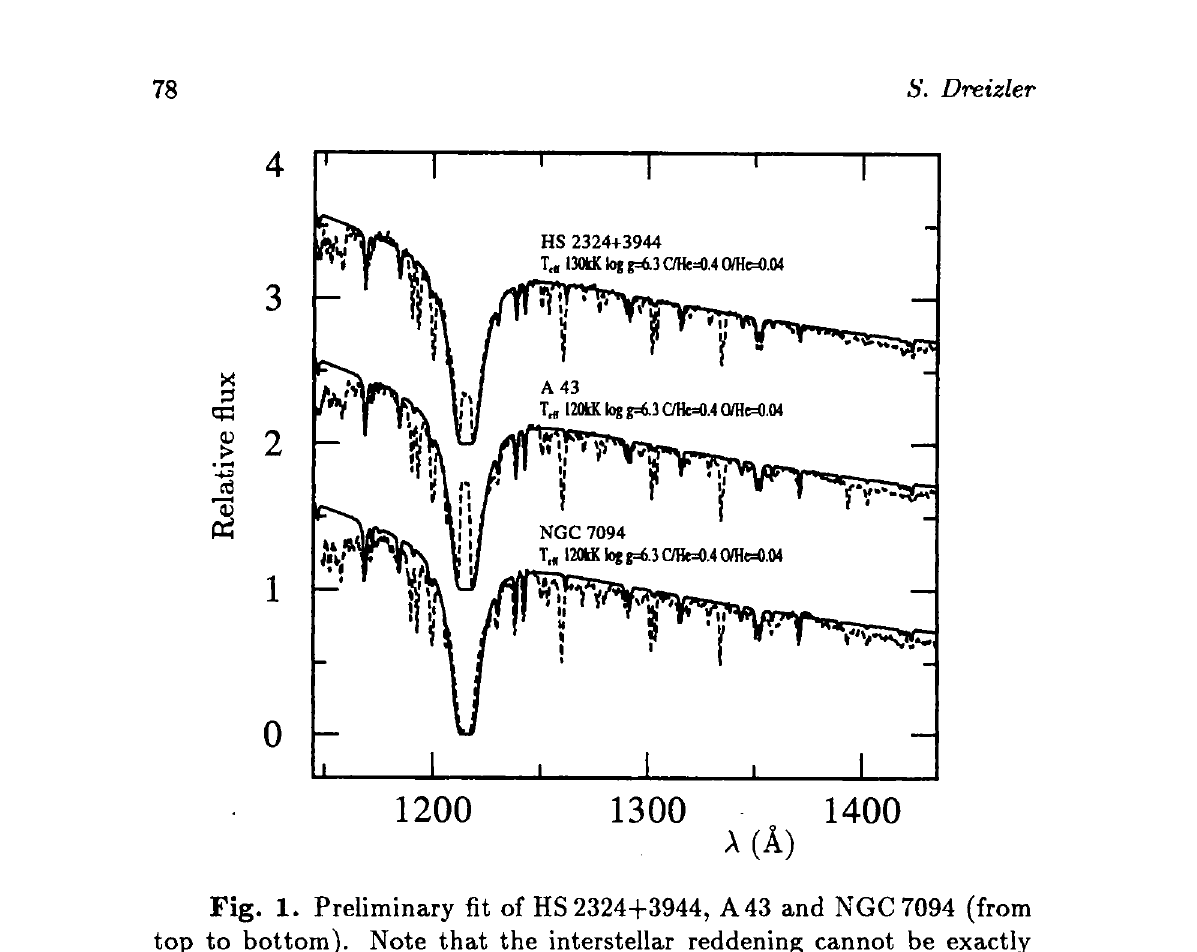
Fig. 1. Preliminary fit of HS 2324+3944, A 43 and NGC 7094 (from top to bottom). Note that the interstellar reddening cannot be exactly corrected with the standard reddening